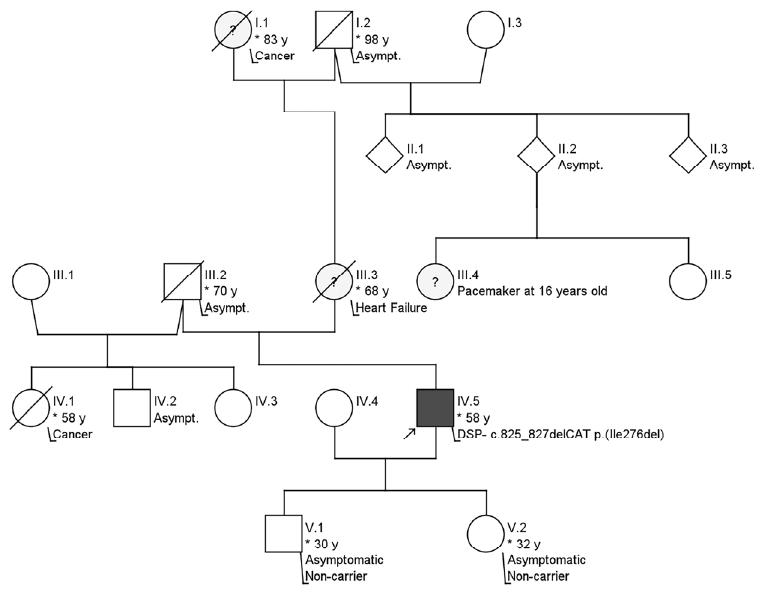
Figure 2. Pedigree of the family. No signs of further hereditary or contributing illnesses were present. IV.5 represents the index patient. * indicates the age in years.